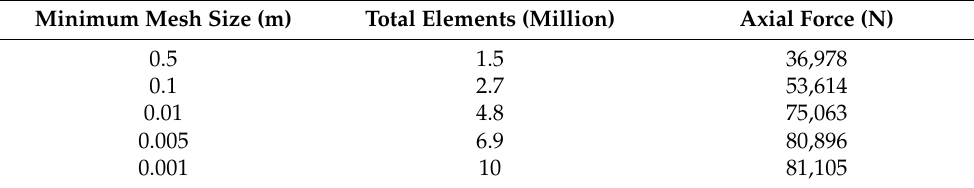
Table 1. Data from mesh sensitivity